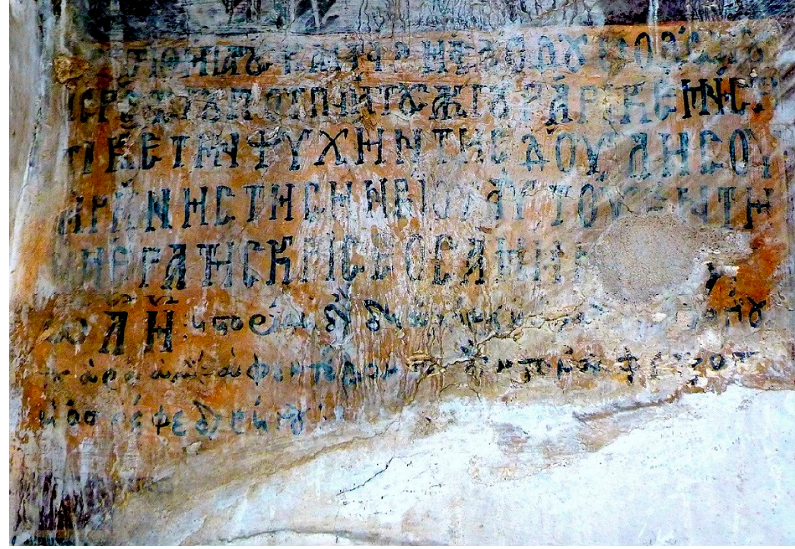
Figure 23. Dedicatory inscription (1330), Hagios Nikolaos Mavrikas (Aegina), south arm of the crossing, west wall. © Author with the permission of the Ephorate of Antiquities of Western Attica, Piraeus, and Islands.